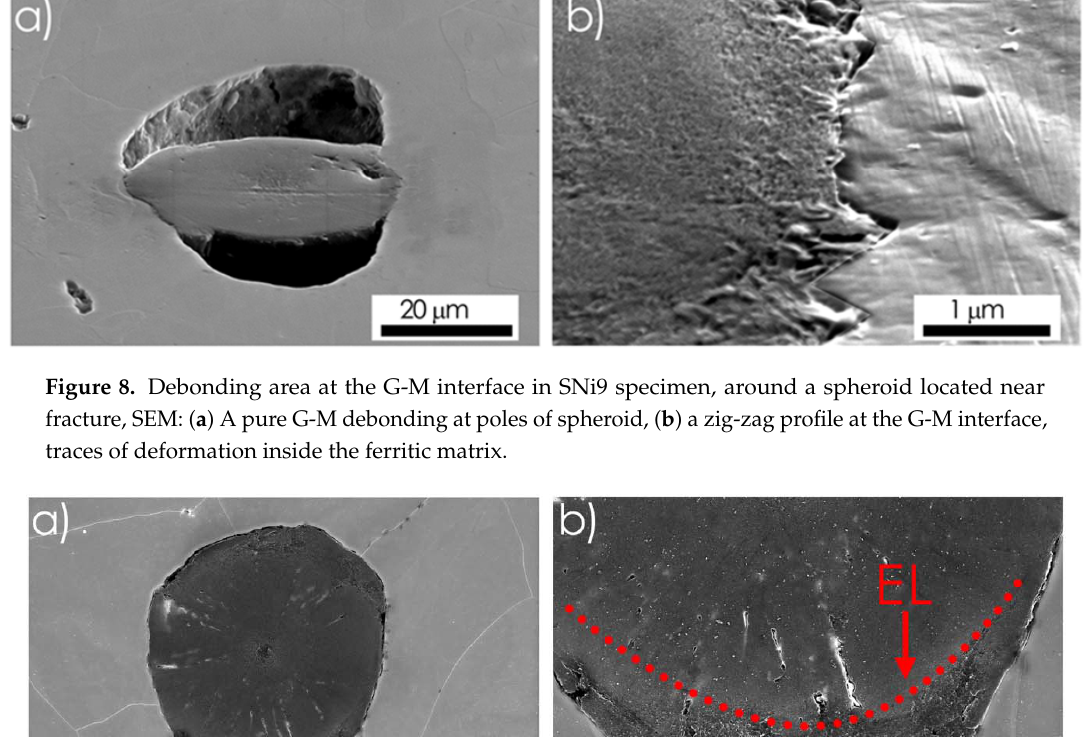
Figure 9. Initial stage of spheroid destruction in SNi9 specimen at a distance of 3 mm from the main fracture surface, SEM: ( a ) Spheroid apparently elongated in tensile stress direction, with local debonding at G ‐ M interface ( b ) outer rim morphology in bottom pole of spheroid (SB: Sector boundary; EL: External layer).